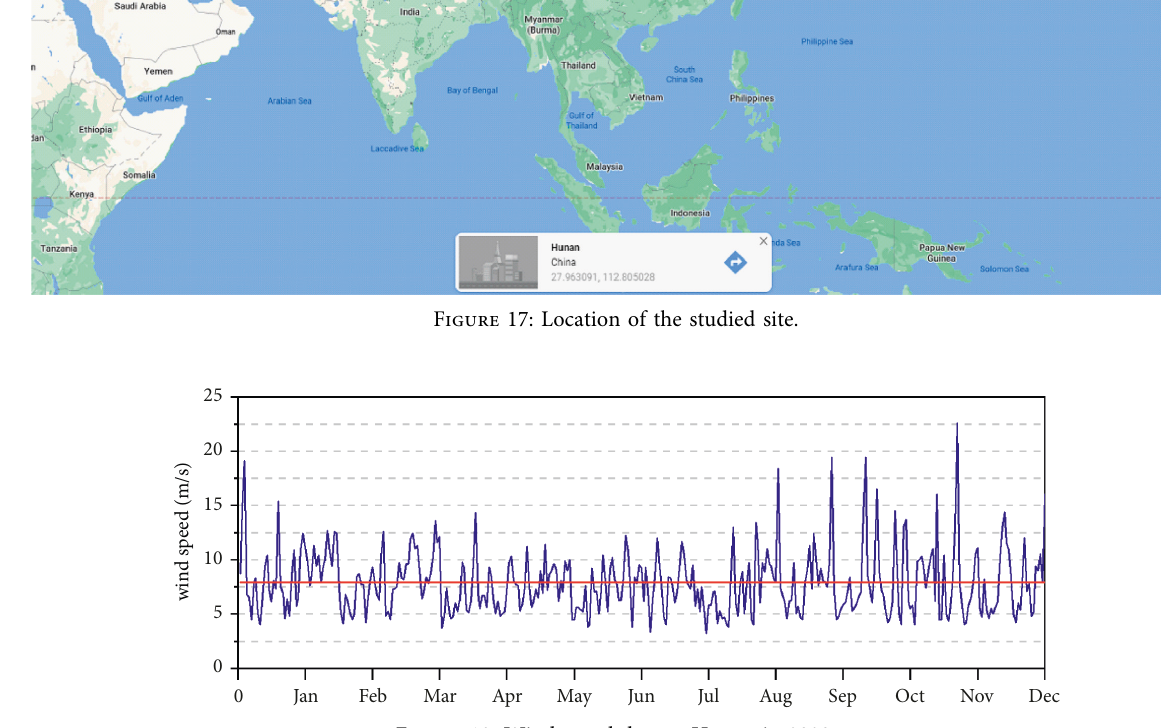
Figure 18: Wind speed data at Hunan in 2020.